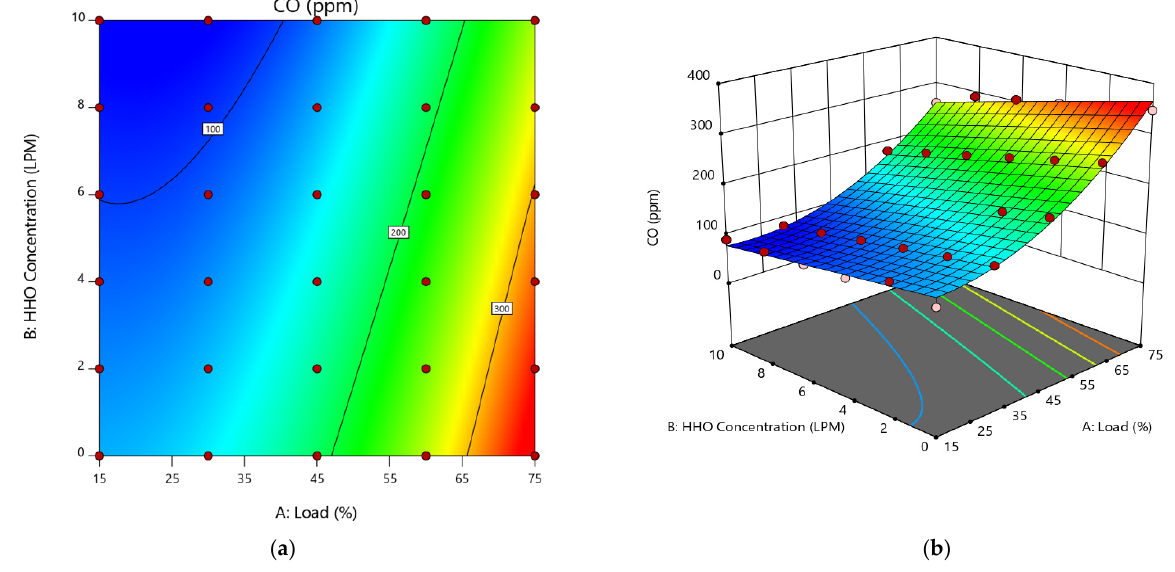
Figure 7. ( a ) Contour plot and ( b ) response surface of CO.